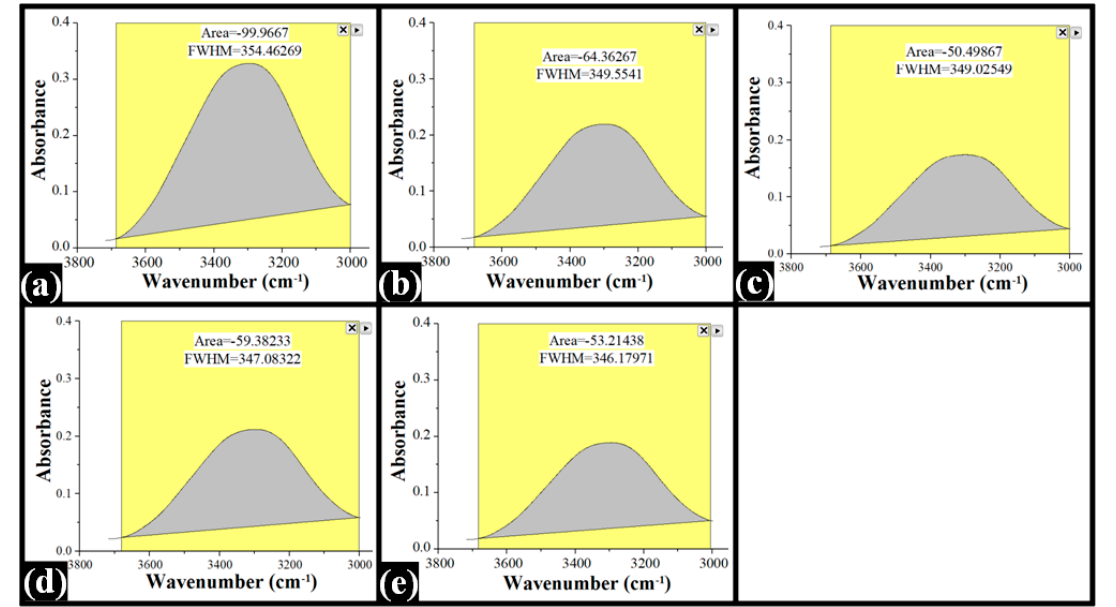
Figure 8. FTIR spectra of composite films (AUP). ( a ) F0; ( b ) F1; ( c ) F2; ( d ) F3; ( e ) F4.